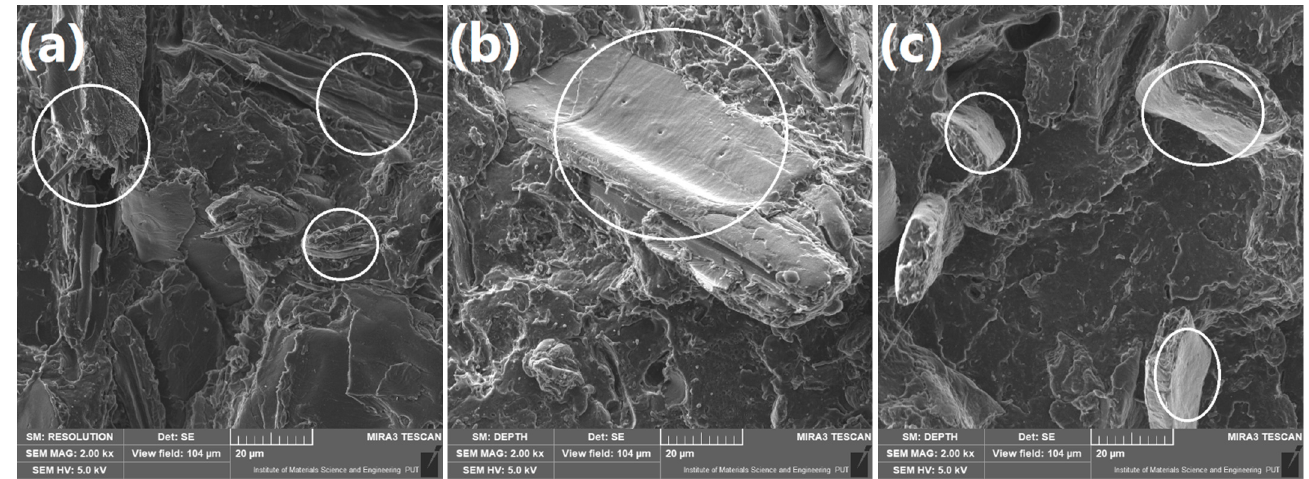
Figure 5. SEM images showing the surface of ( a ) WF, ( b ) BSG, and ( c ) ŁK particles.